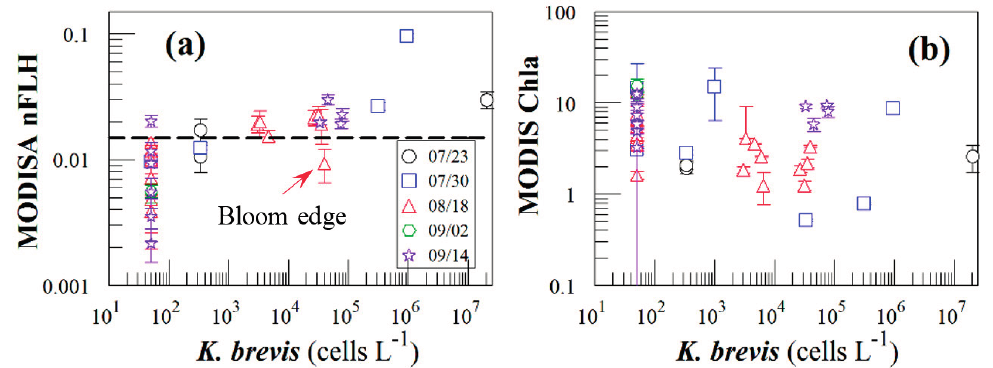
Figure 9. Comparison between MODISA data (nFLH in ( a ) and Chla (in ( b )) and near-concurrent (±1 day) K. brevis concentrations for 6 HAB bulletins on 07/23, 07/30, 08/08, 08/18, 09/02, and 09/14/2014. Data for 08/08 is missing due to cloud cover. The dashed line in ( a ) represents nFLH = 0.015 mW·cm − 2 · μ m − 1 ·sr − 1 . Chla has units of mg·m − 3 . Concentrations of 0 are artificially lifted to 50 in order to display on the log scale. In ( a ), there are 19 data points with K. brevis < 1000 cells·L − 1 and 14 data points > 1000 cells·L − 1